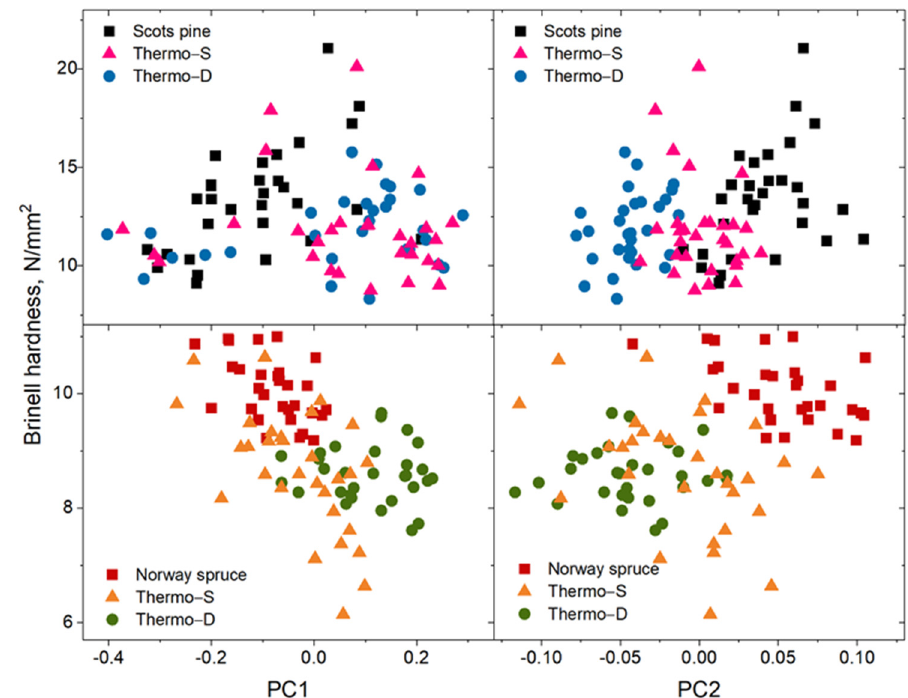
Figure 11. Brinell hardness measured after release of the force plotted as a function of PC1 and PC2 scores for untreated and ThermoWood ® Norway spruce and Scots pine.